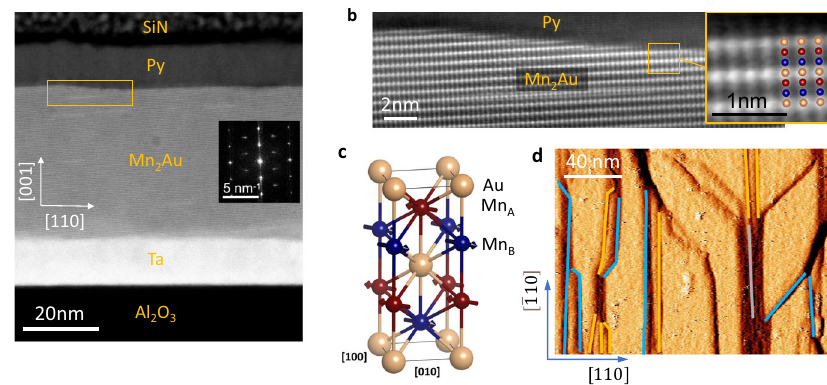
Fig. 1 Structure of the samples. a Cross section HAADF STEM image of the entire stack viewed along the [ (cid:1) 110]-direction of Mn 2 Au(001). The inset shows a local Fourier transform of the Mn 2 Au region. b Magni fi ed image of the Mn 2 Au/Py interface (region indicated by a rectangle in a ), where Au atom columns have bright contrast. The inset shows a higher magni fi cation image overlaid with a model of the crystal structure. c Crystal structure of Mn 2 Au with the magnetic moments pointing along the easy [ (cid:1) 110]-direction. d STM image of a pristine Mn 2 Au(001) thin fi lm surface with steps corresponding to half unit cells (0.42 nm) indicated by the yellow lines, one unit cell (0.85 nm) indicated by the blue lines, and three unit cells (2.55 nm) indicated by the gray